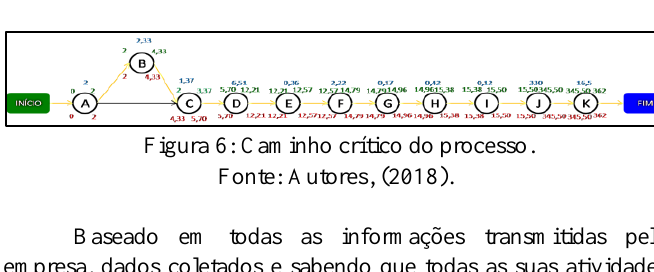
laranja conforme figura abaixo: